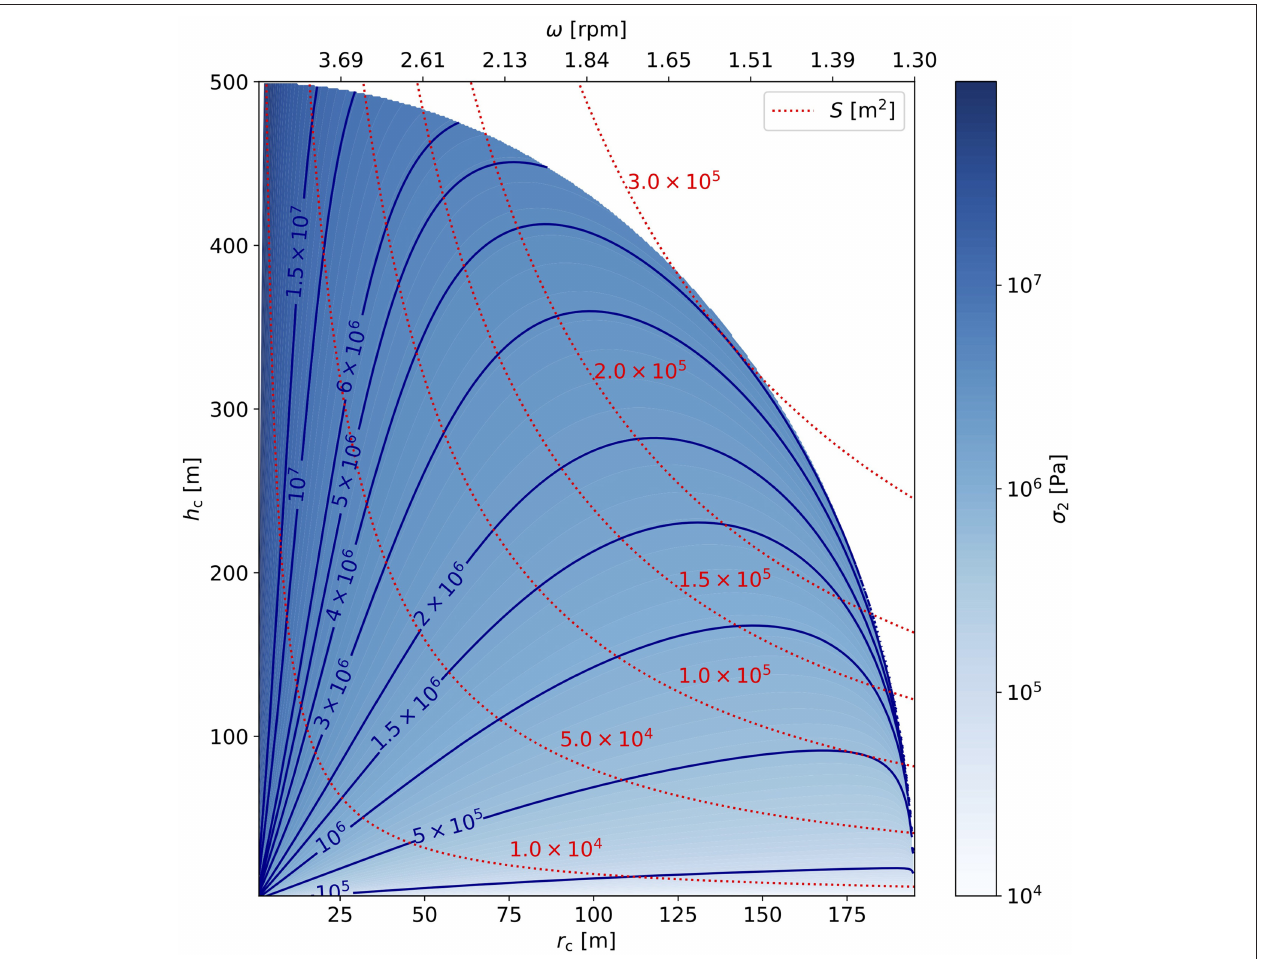
FIGURE 7 | Model 2 results for artificial gravity of 0.38g E in a space station of radius r c and height h c , the color code and the blue contour lines give the combined tensile and shear stress resulting from the required rotation rate obtained via (9). The red dotted lines give the usable surface area S of the space station, the upper x -axis denotes the required rotation